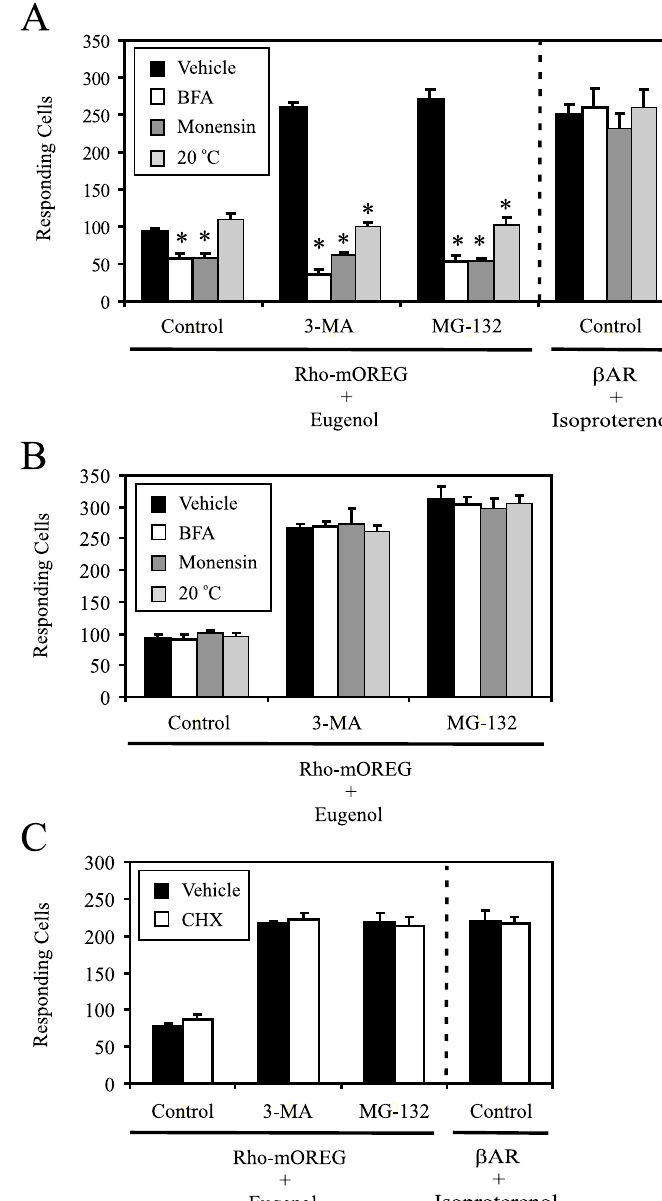
Figure 5 ER export and trafficking through the Golgi apparatus are required for Rho-mOREG functional expression. CNG cells transiently transfected with Rho-mOREG were assayed for increases in intracellular calcium in response to 10 uM eugenol, to gauge Rho-mOREG function, or 1 nM isoproterenol, to gauge β -AR function, following treatment with vehicle (0.1% ethanol), BFA (5 ug/ml), monensin (10 uM), or incubation at 20°C for 4 h (A) or 5 min (B). (C) Cells were treated with vehicle or CHX (75 uM) for 4 hr. In all experiments, cells were also co-treated for 4 h with control (0.1% DMSO), 10 mM 3- MA, or 50 uM MG-132 as indicated. Partial inhibition of Rho-mOREG function with BFA or monensin but not 20°C (A, control columns), a temperature that also attenuates endocytic events, is likely attributable to turnover of cell surface Rho-mOREG when the biosynthetic pathway, which normally replenishes the plasma membrane Rho-mOREG pool, is blocked. By contrast, BFA and monensin do not affect function of the β -AR, a control GPCR that exhibits a long half-life at the plasma membrane [31]. * p < 0.005 compared to cells treated with vehicle in the same